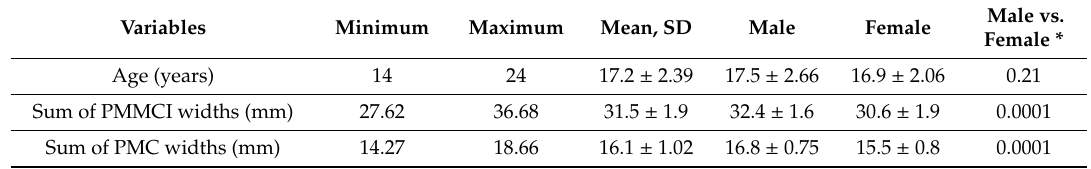
Table 1. Comparison in age and sum of widths of examined teeth between males and females ( n = 100). Variables